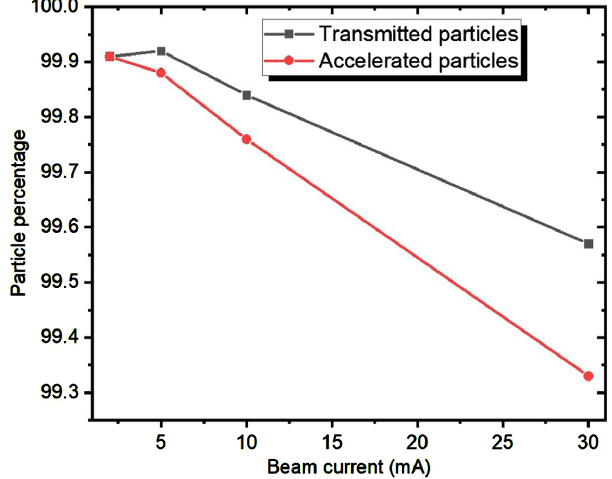
FIG. 8. Beam transmission (transmitted and accelerated parti- ces) through the RFQ as a function of beam current.